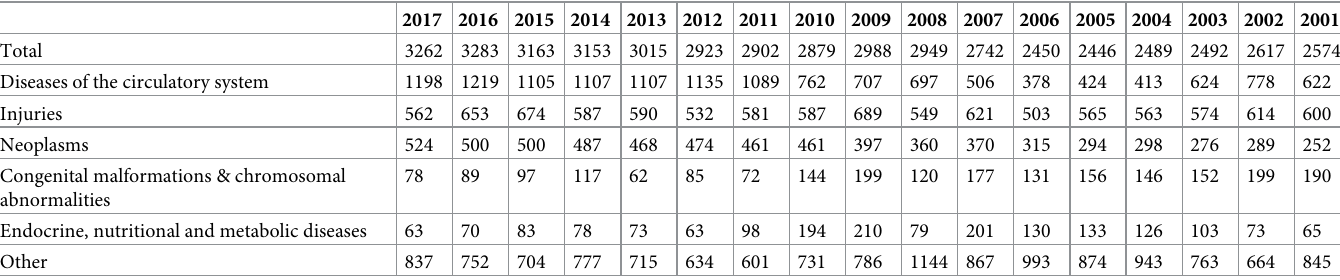
Table 1. Causes of death in the emirate of Abu Dhabi,